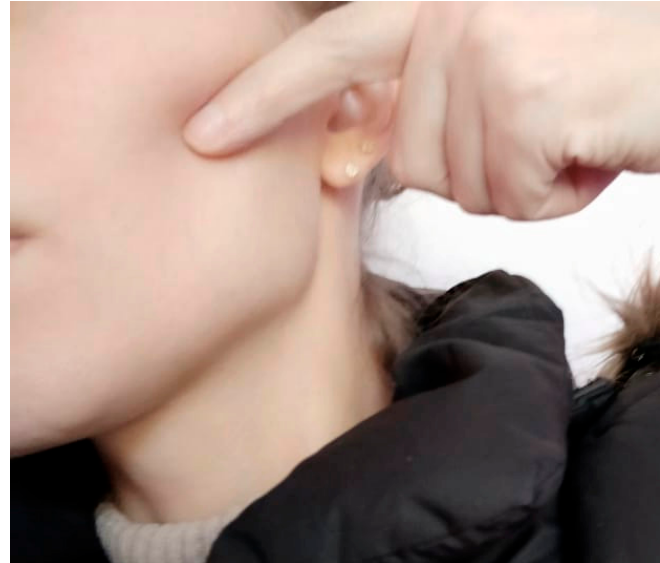
Figure 5. Site where the patient localized the origin of her facial pain.